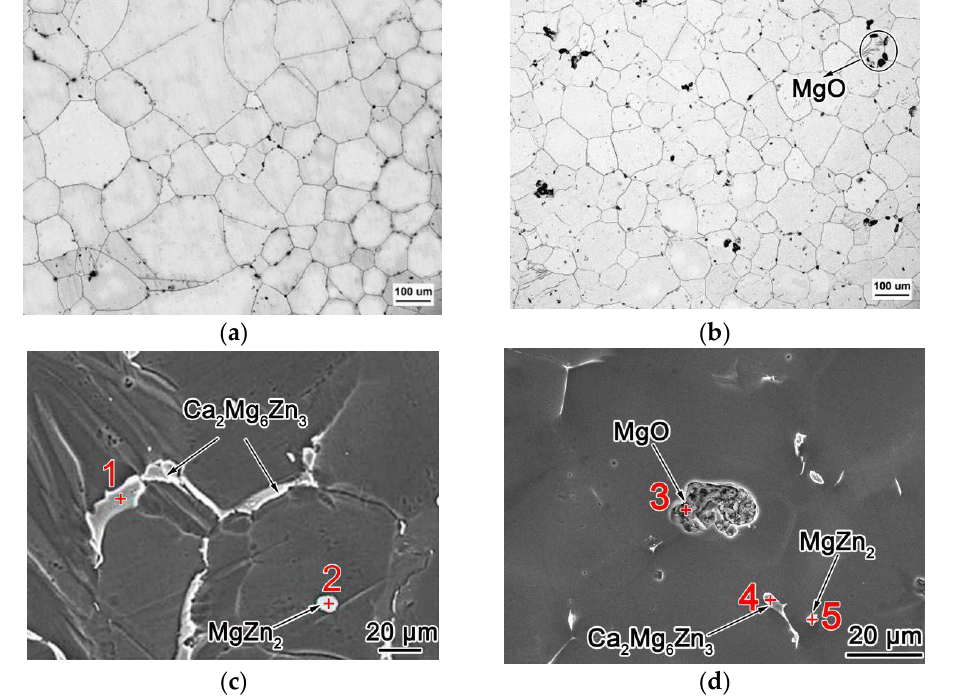
Figure 1. Optical microscope (OM) images ( a , b ) and SEM images ( c , d ) of homogenized MZC ( a , c ) and MZCM ( b , d